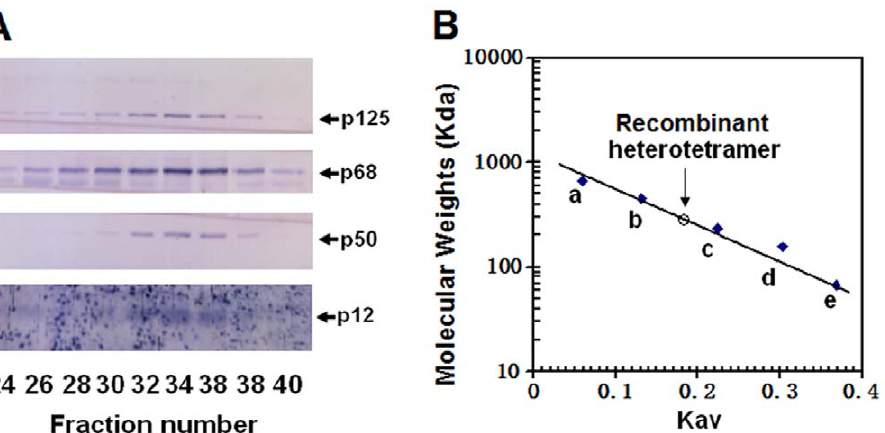
Figure 7. Molecular weight determination of recombinant pol d heterotetramer complex. A 250 m l of sample from Mono Q peek fraction 15 was passed through a Superdex 200 column precalibrated with molecular weight standards. Panel A: The fractions across the peak of polymerase activity were run on 12.5% SDS-PAGE and Western-blotted with the indicated antibodies. The pol d four subunits are marked by arrows. Panel B: The diagram shows the calibration of the column that was used to estimate the molecular weight. The standards used here were: a, thyroglobulin (667,000); b, ferritin (445,000); c, catalase (232,000); d, aldolase (158,000); e, bovine serum albumin (67,000). The elution position of the recombinant heterotetramer complex is indicated by a vertical arrow. A calibration curve was plotted by the logarithm of molecular weights versus calculated Kav.